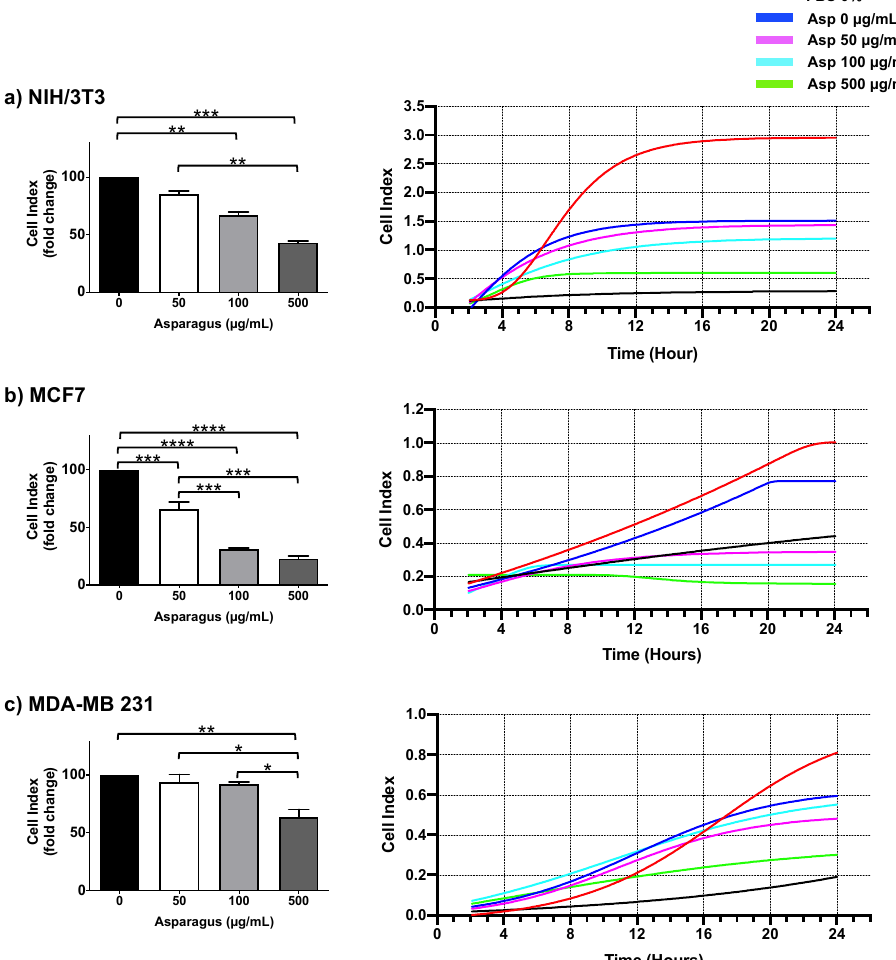
Figure 8. NIH-3T3 ( a ), MCF7 ( b ) and MDA-MB231 ( c ) cells were seeded in the upper chamber of CIM plate and monitored for migration through the lower chamber in response to different concentrations of Asp (0–500 µ g/mL) with the xCELLigence system (DP-RTCA) for 24 h. Positive controls were performed by using medium with 10% FBS in the lower chamber as the chemoattractant, while negative controls were performed by using medium without FBS (0% FBS). In the left panels, data are expressed as fold change compared to untreated cells of results from three independent experiments and are reported as mean ± standard error. Statistical analysis was performed by ANOVA followed by Bonferroni’s post hoc test. p -values ≤ 0.05 were considered significant: * p ≤ 0.05, ** p ≤ 0.005, *** p ≤ 0.001 **** p ≤ 0.0001. Right panels show representative graphs from RTCA software reporting overtime cell index.